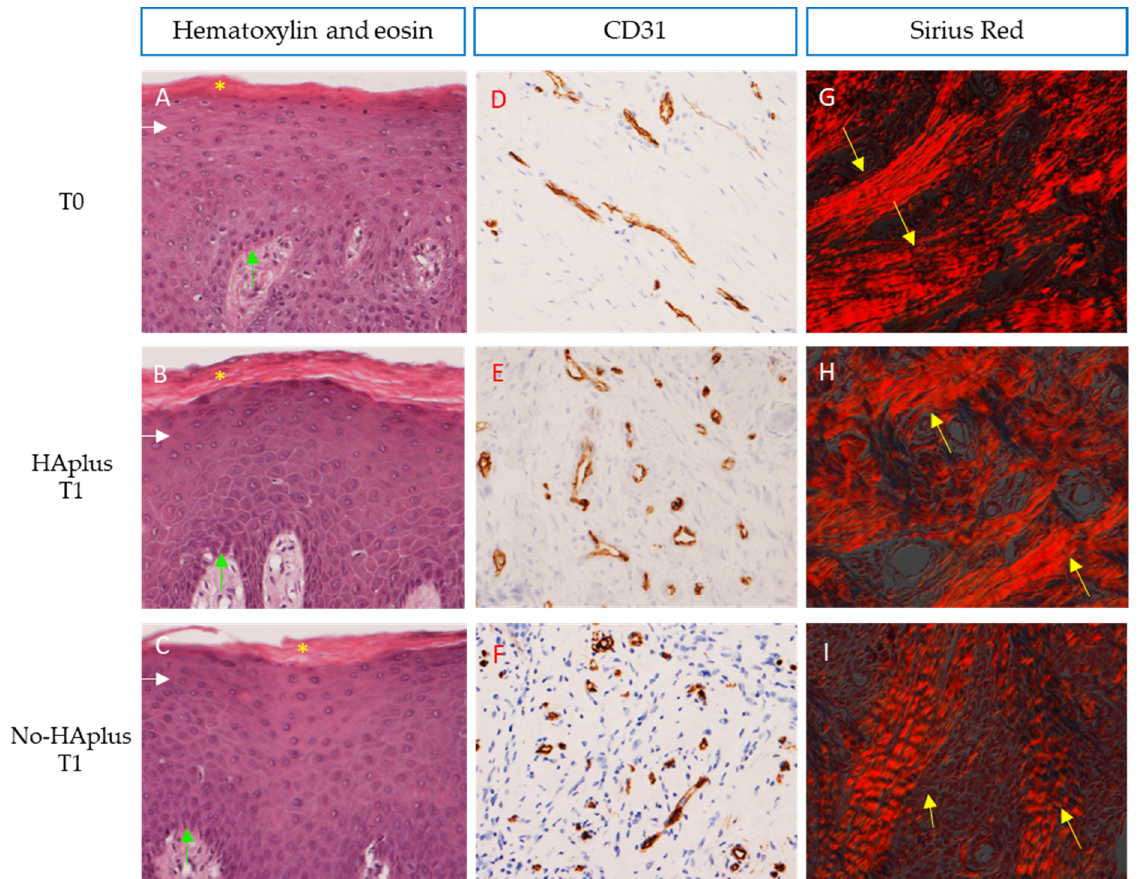
Figure 2. Gingiva: ( A – C ) Sections demonstrate the integrity and normal stratification of the epithelium at the healing site. Pluri-stratified squamous epithelium with ortho- and para-keratinization is depicted in pink and indicated with yellow asterisks, while basal (light blue arrows) to granular layers (white arrows) of epithelium are shown in purple. Carazzi’s H&E, total magnification 200×. ( D – F ) Sections stained with CD31 in brown demonstrate differences in microvascular distribution for each group. Immunostaining anti-CD31, total magnification 200×. ( G – I ) Sections highlighted under polarized light showing the orientation and distribution of collagen fibers in red. More evident collagen bundles are indicated with yellow arrows. Sirius red/Picric Acid, total magnification 200×.